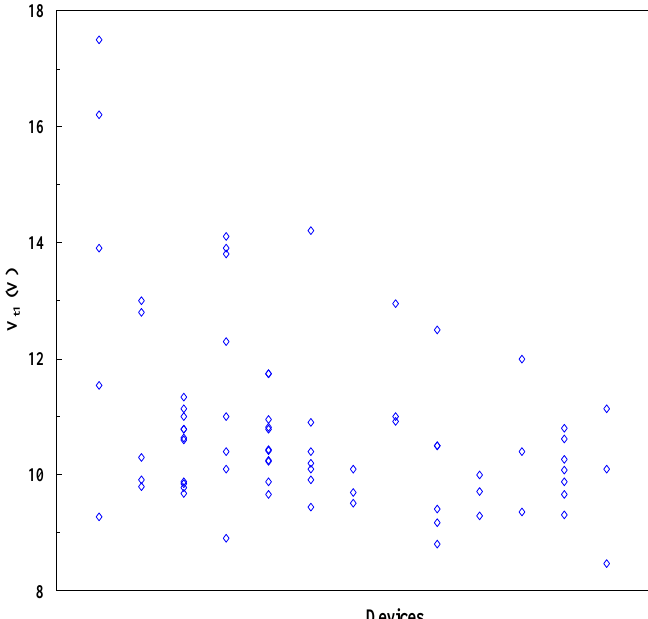
Figure 20. TLP measurement shows a wide range of ESD V t1 values for prototype gNEMS switches, adjustable by device design variations [36].